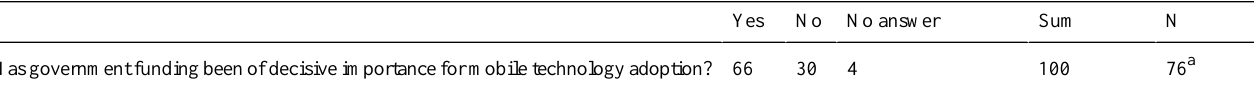
Table 2. The importance of government funding for mobile technology adoption (%) (source: Survey to home care managers in all 98 municipalities).